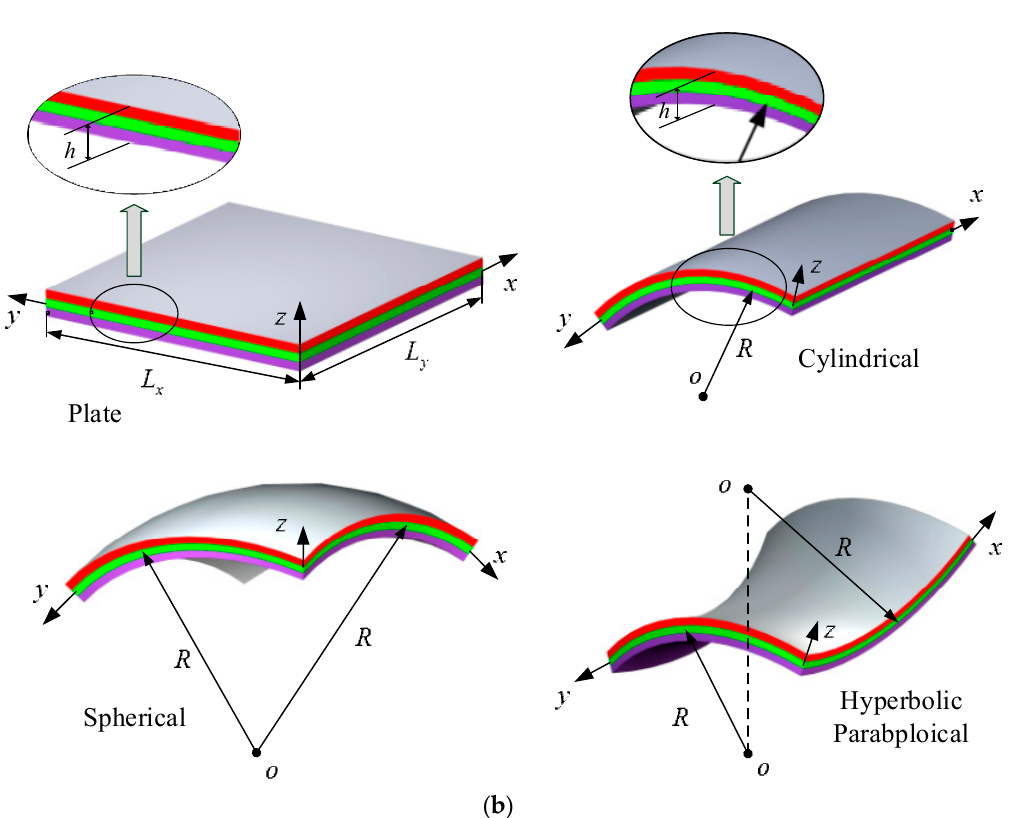
Figure 1. ( a ): Geometric model of the composite laminated shallow shell with elastic restraint; ( b ): geometric model of the composite laminated shallow shell with various curvature types.